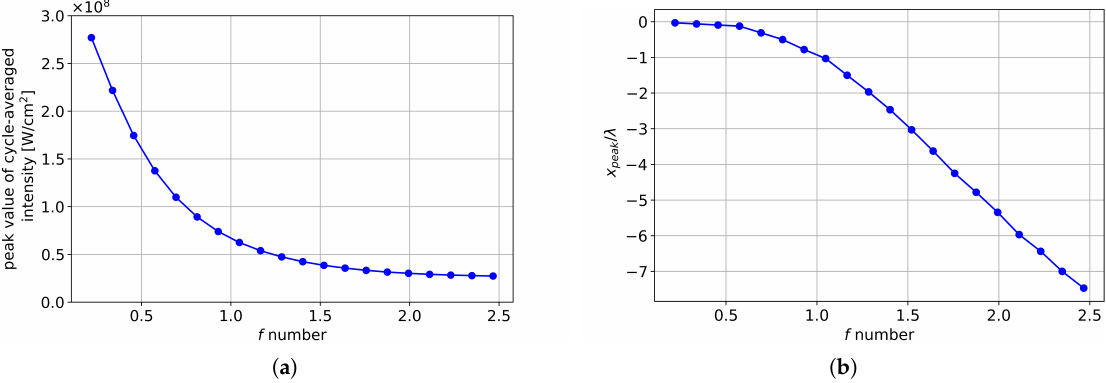
Figure 6. The dependence of ( a ) the peak value of cycle-averaged intensity on f-number and ( b ) the coordinate x at which the peak is reached, at a fixed peak power P 0 = 1 W and wavelength λ = 1 µ m (see the explanation in the text).